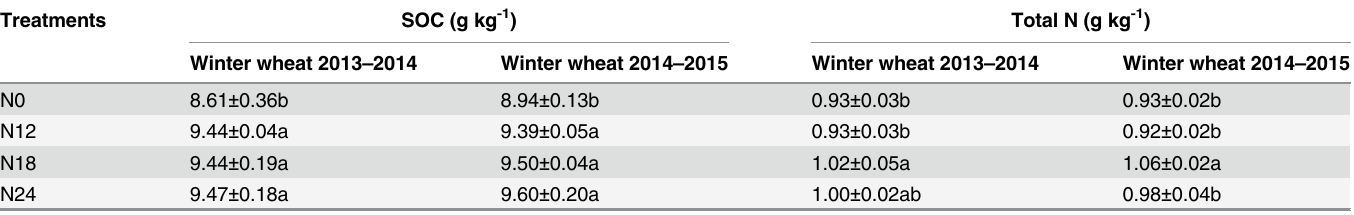
Table 4. SOC and total N content among various N treatments at maturity stage.